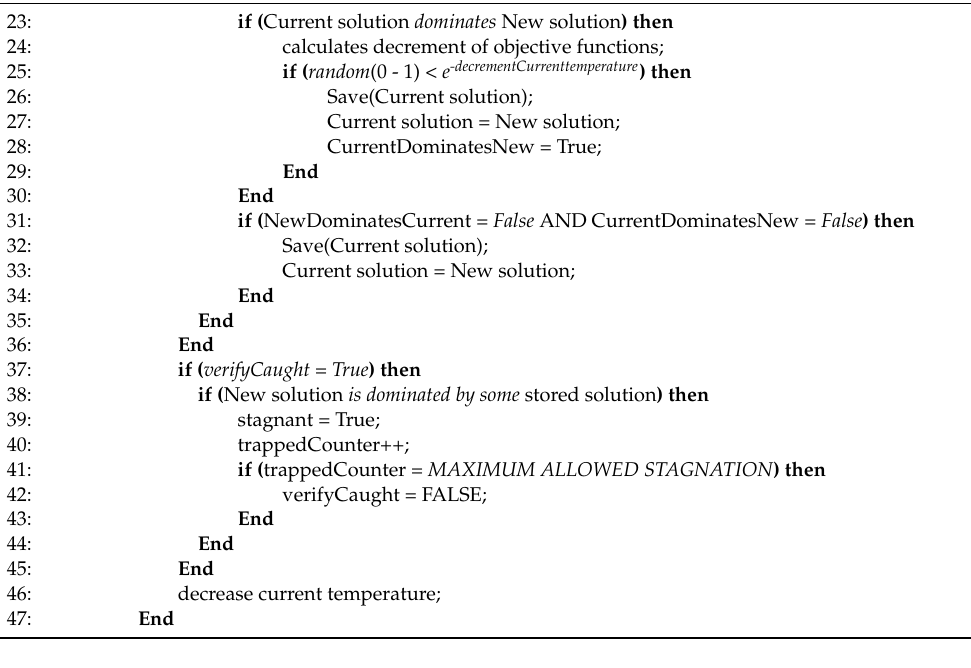
Algorithm 3. Improvement method: Chaotic Multi-Objective Simulated Annealing